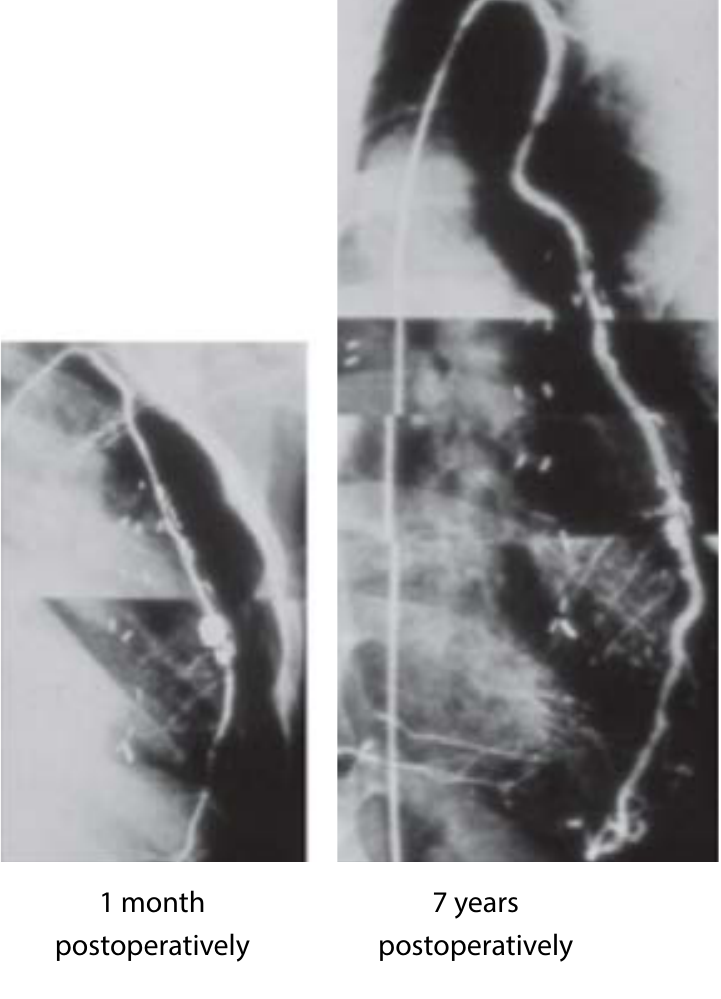
Fig. 4 – The longitudinal growth of the internal thoracic artery in accordance with the somatic development of the child from 1 month to 7 years after coronary artery bypass grafting. The growth potential is obvious, without any degenerative changes in the graft